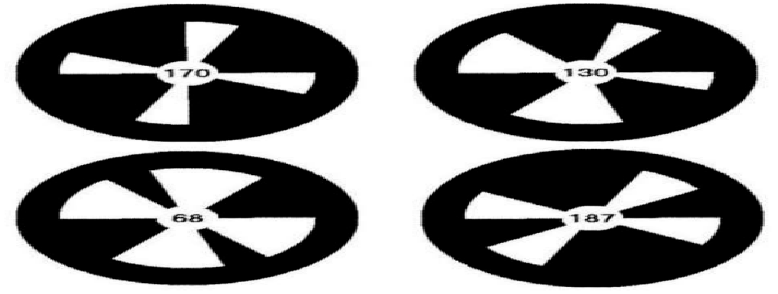
Figure 8. Some of the NAO markers